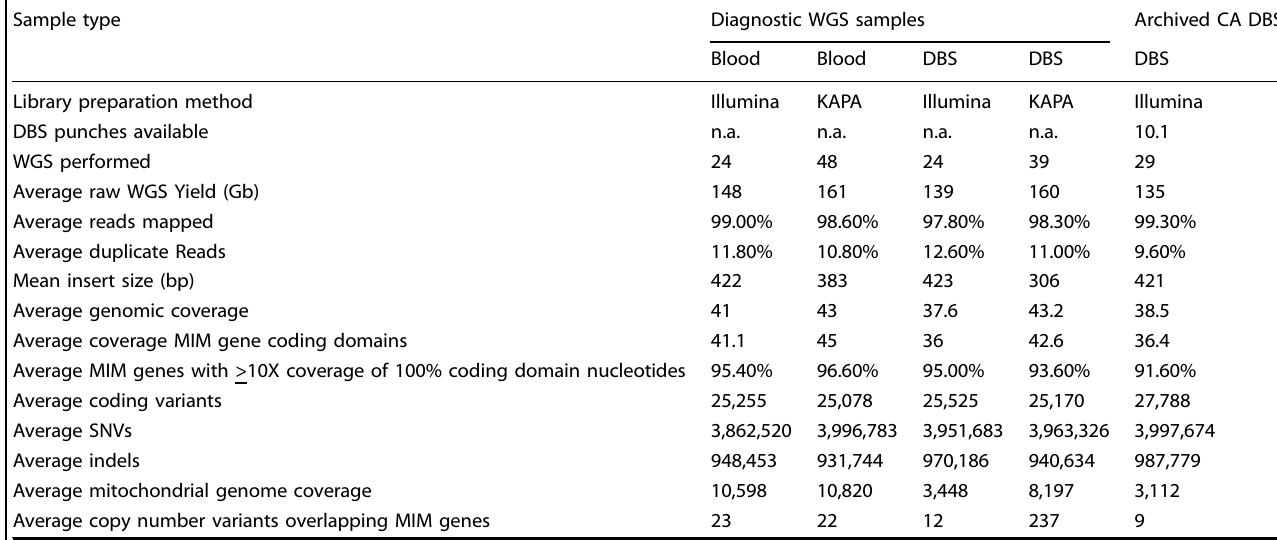
Table 2. Quality of diagnostic WGS of 25 blood samples (controls) compared with WGS from 63 DBS made from those blood samples and 29 archived California newborn